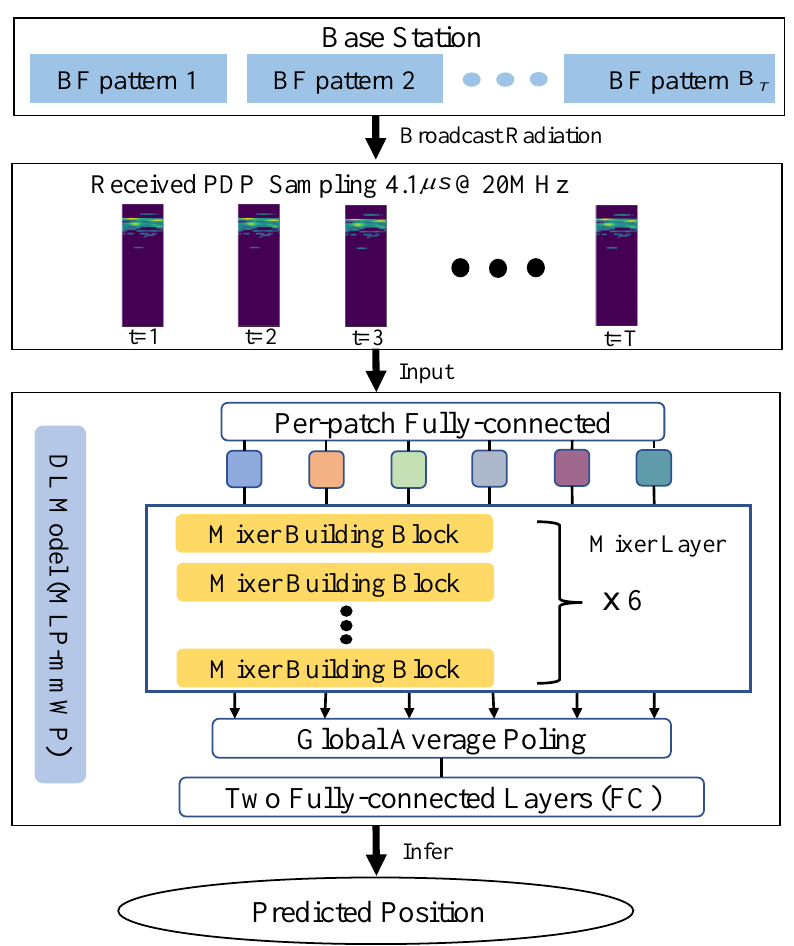
Figure 2. The overall scheme of system modeling and the problem definition of MMW